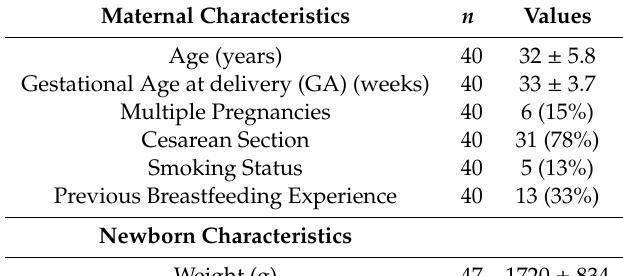
Table 1. Clinical characteristics and characteristics of the milk samples.